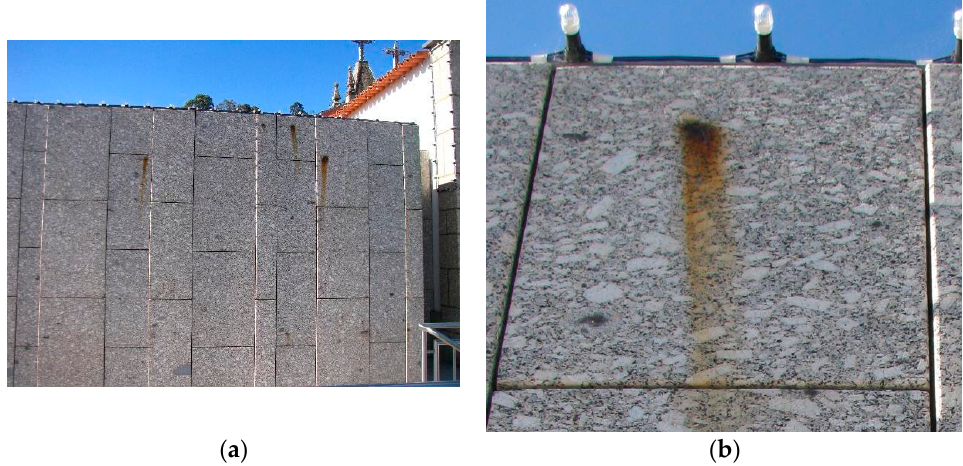
Figure 2. Oxidation stain associated with the presence of iron sulfides in granite stones on the wall of a contemporary structure: ( a ) general view showing several stains; ( b ) detail of one of the stains showing the stain crossing the boundary between two stones.